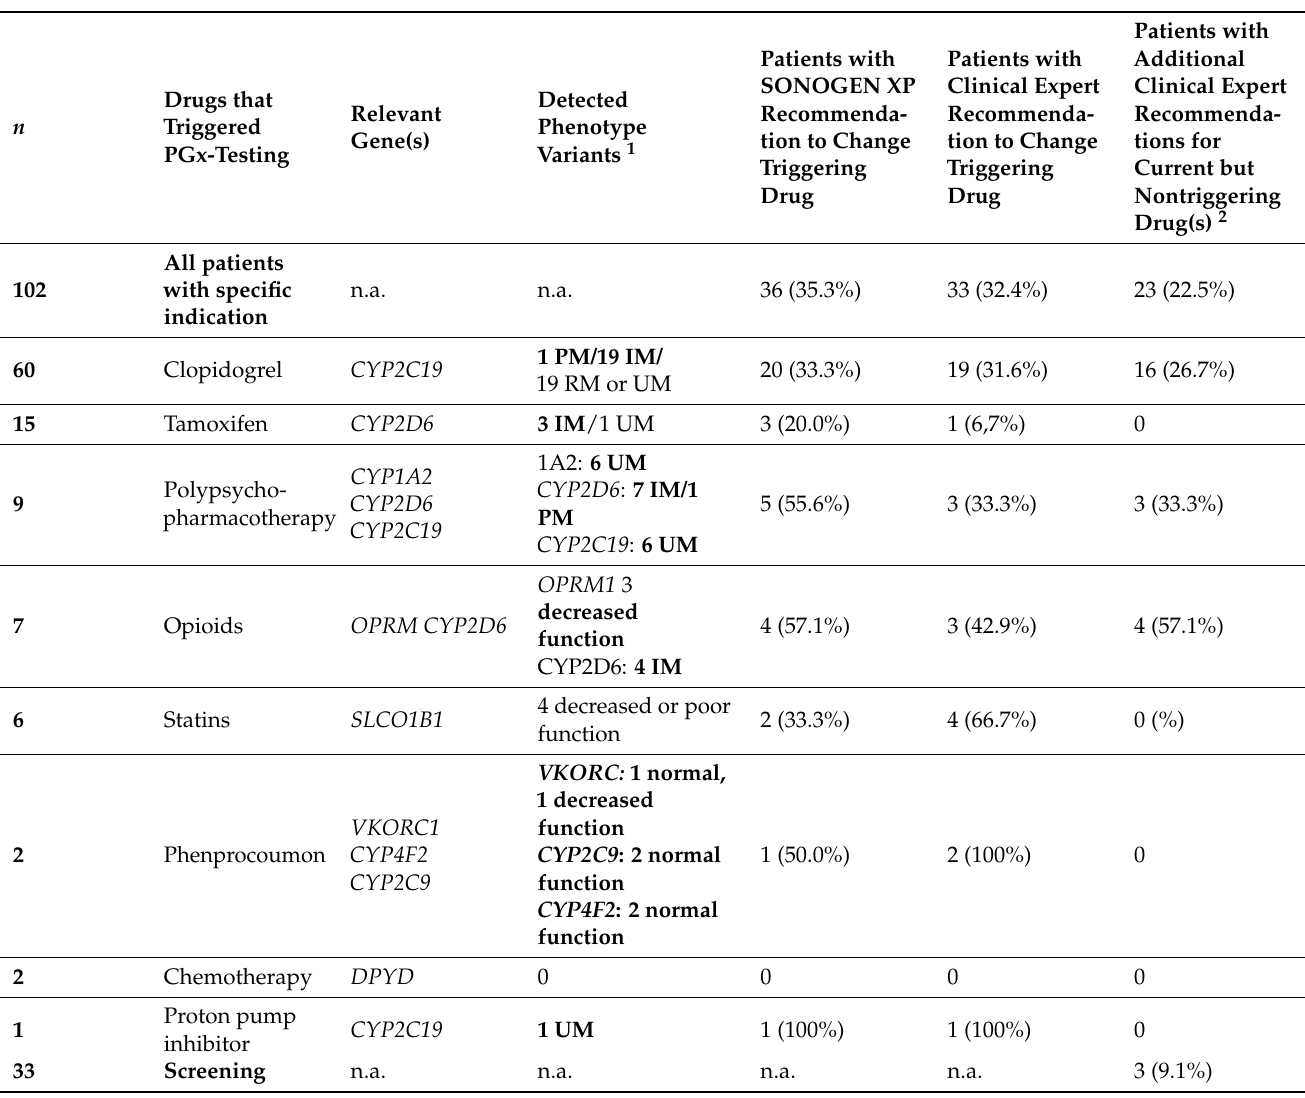
Table 3. Drugs triggering PGx-testing, detected phenotype variants and recommendations to change patients’ current